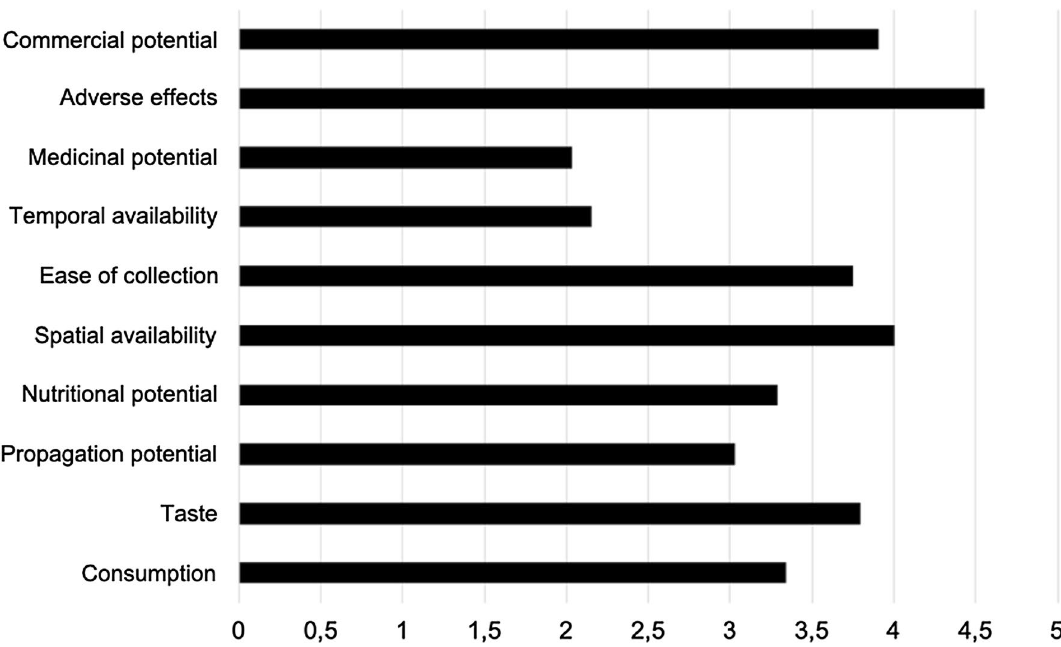
Figure 2. Average scores for the attributes of wild food plants according to the perception of residents of the rural settlement Dom Helder Câmara, in the municipality of Murici, state of Alagoas, northeastern Brazil.